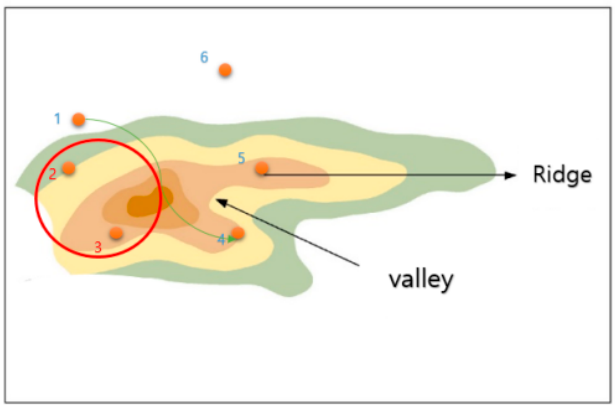
Figure 26. Progress path according to the waypoint expressed in OpenCV.